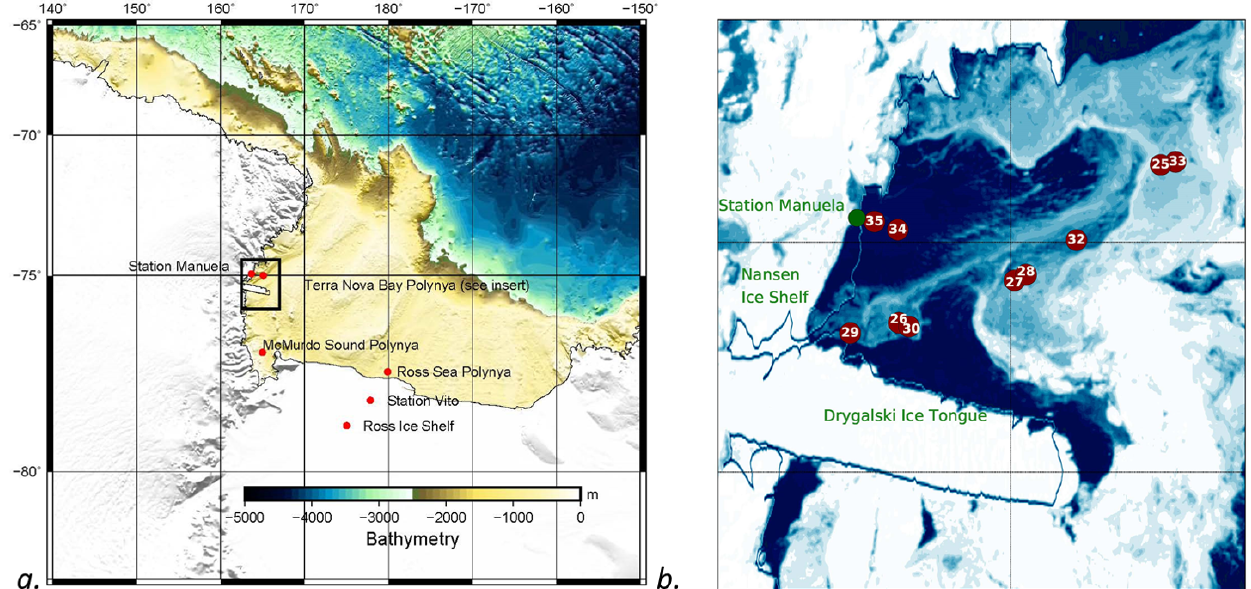
Figure 2. Map of the Ross Sea and the Terra Nova Bay polynya. (a) Overview of the Ross Sea, Antarctica, highlighting the locations of the three recurring polynyas: Ross Sea polynya (RSP), Terra Nova Bay polynya (TNBP), and McMurdo Sound polynya (MSP). Bathymetry source: GEBCO 1 ◦ grid. (b) Terra Nova Bay polynya insert as indicated by black box in panel (a) MODIS image of TNBP with the 10 CTD stations with anomalies shown. Not included is CTD Station 40, the one station with an anomaly located in the RSP. (CTD Station 40 is represented in Fig. 2a as the location of the Ross Sea polynya.) Date of MODIS image is 13 March 2017; MODIS from during cruise dates could not be used due to the lack of daylight and high cloud